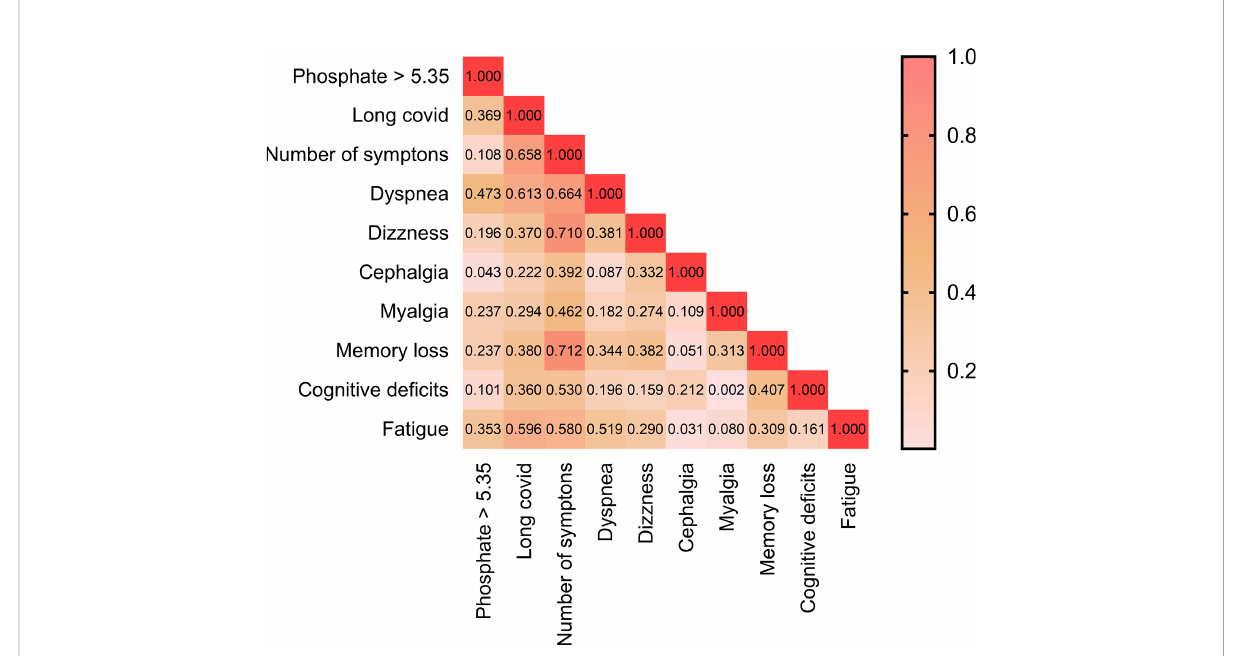
FIGURE 3 Heat map of the correlation matrix between phosphate ≥ 5.35 with each post COVID